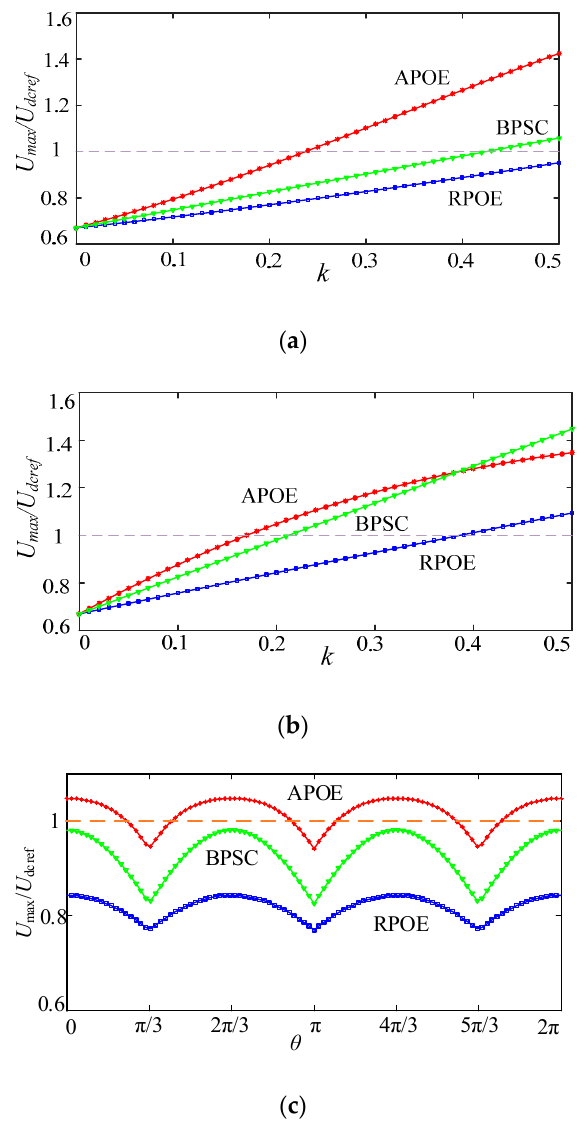
Figure 7. Relationships among the maximum voltage amplitude, unbalanced factor and the phase angle of negative sequence voltage. ( a ) When θ is π /3. ( b ) When θ is 2 π /3. ( c ) When k is 0.2.